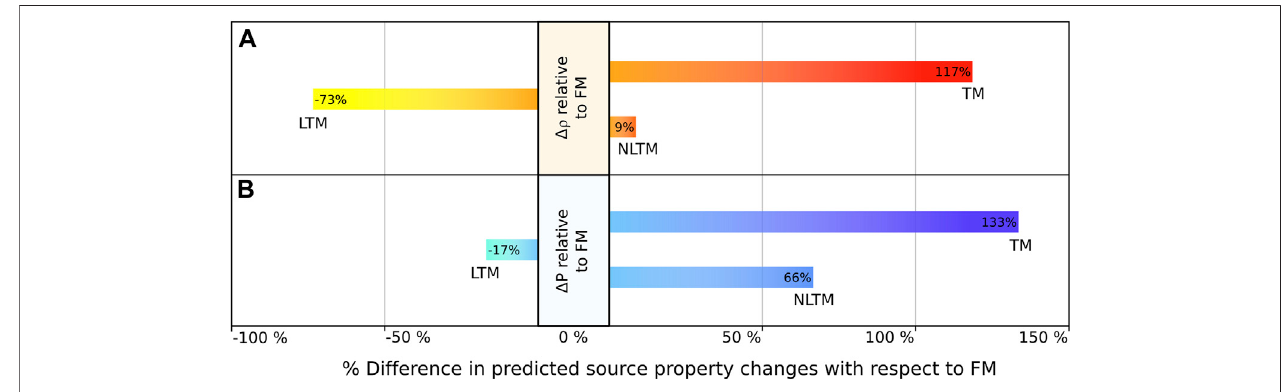
FIGURE 7 | Percentage difference in reservoir parameter changes from TM, LTM and NLTM with respect to the FM to produce minimum detectable mass and volume changes upon magma recharge (see also Table 5 ). (A) displays the % changes in the predicted Δ ρ values, whilst (B) gives the % changes in the predicted Δ P